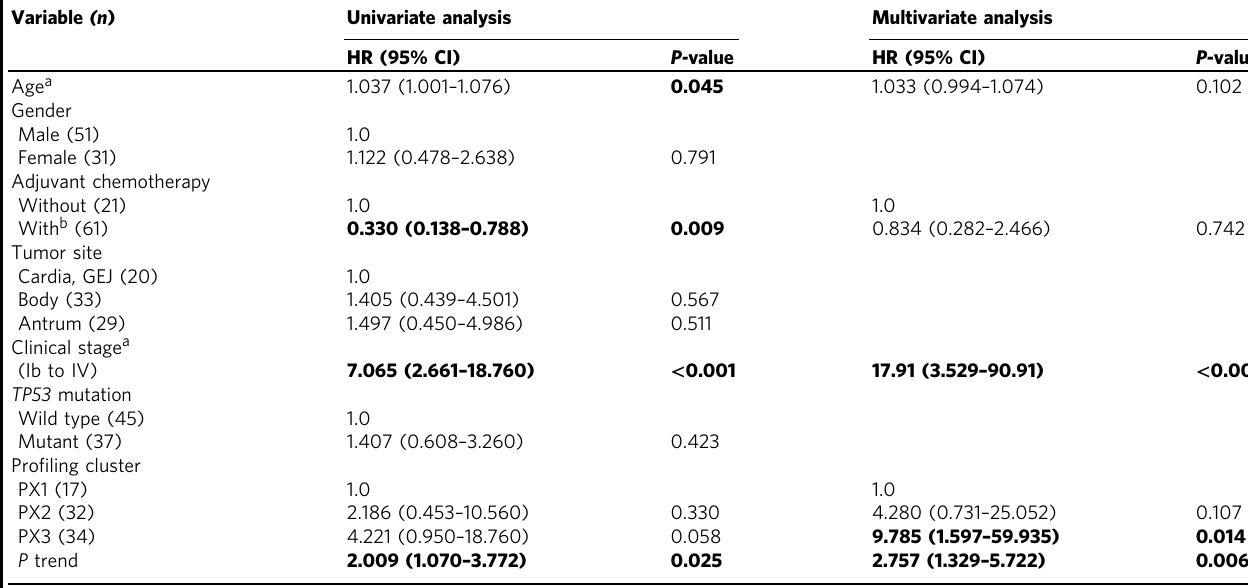
Table 1 Univariate and multivariate analysis of overall survival in 82 patients Variable (n ) Univariate